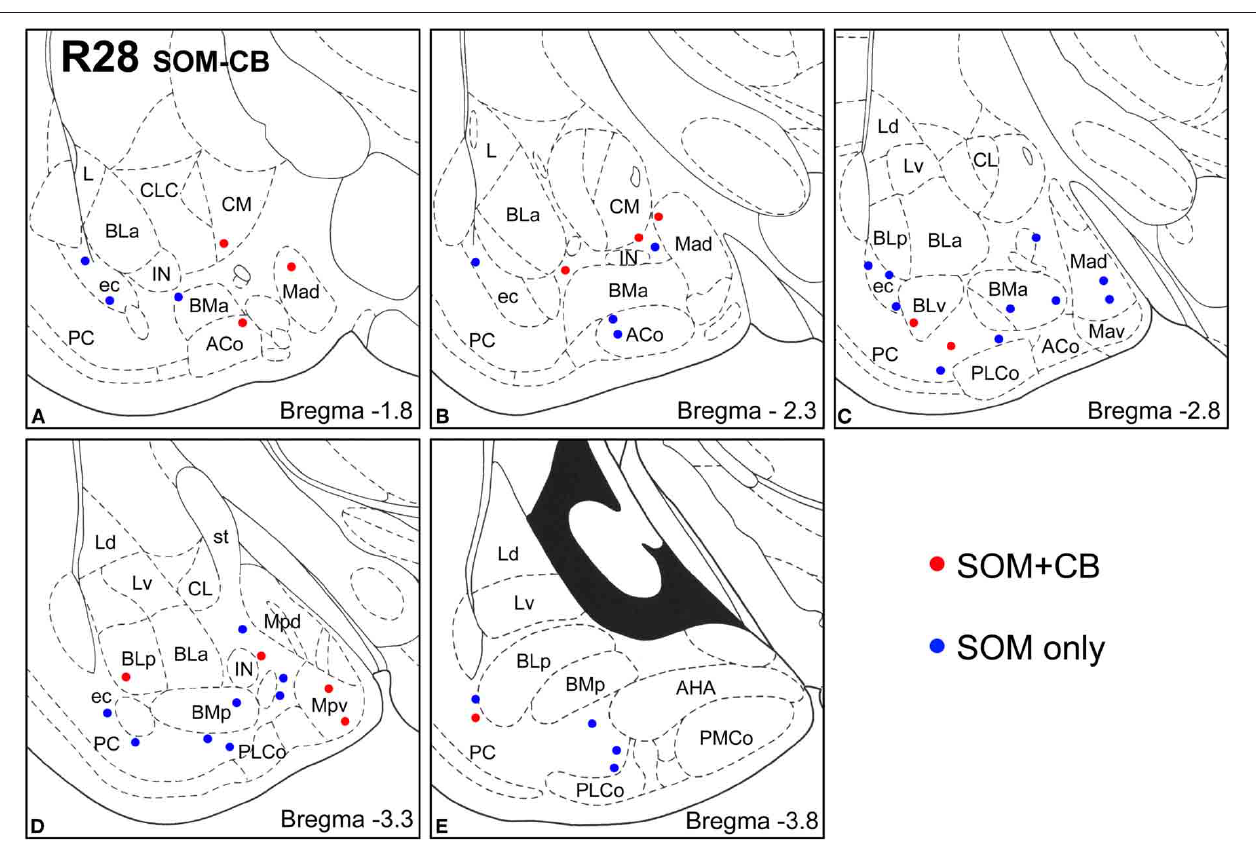
FIGURE 7 | Sections arranged from rostral (A) to caudal (E) depicting the locations of long-range non-pyramidal neurons in the amygdalar region expressing SOM and CB in case R28. Each dot represents one neuron.